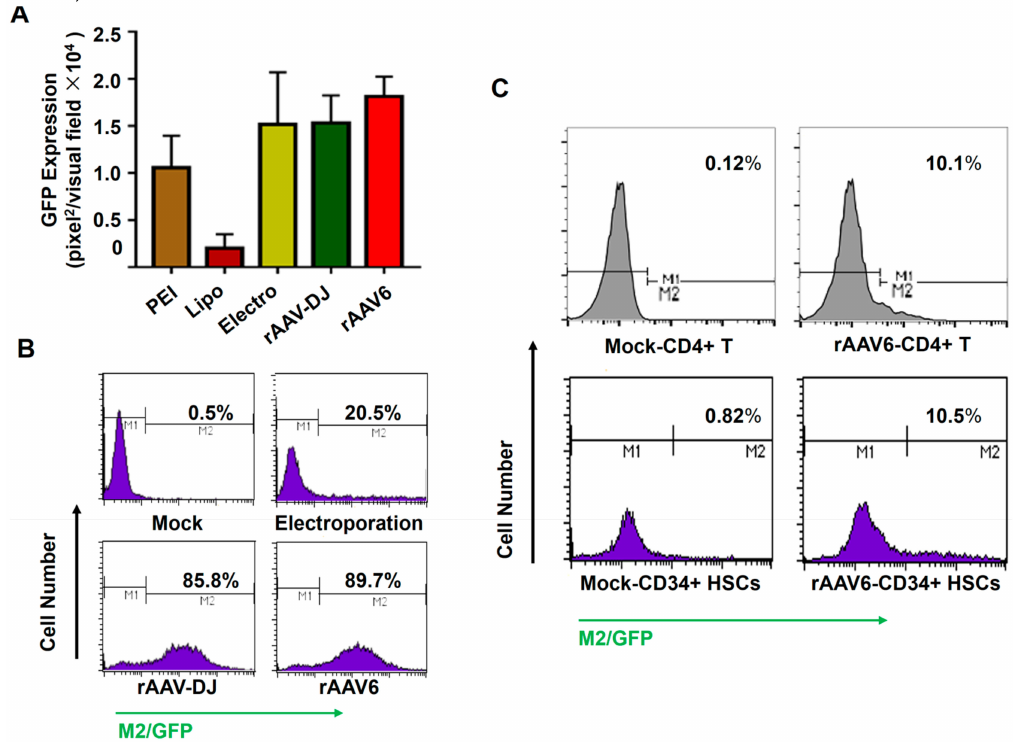
Figure 1. Capsid-optimized recombinant adeno-associated virus serotype 6 (rAAV6) vectors represented the most e ffi cient gene delivery method for hematopoietic cells. ( A ) K562 cells were transduced with the gfp gene through various indicated methods. Transgene expression was detected by fluorescence microscopy at 72 hours post-transfection or post-viral transduction. ( B ) Transgene expression from ( A ) was measured by flow cytometry. ( C ) Primary human CD4 + T cells and CD34 + hematopoietic stem cells (HSCs) were transduced with rAAV6-CMVp- gfp vectors at 10,000 vgs / cell. Transgene expression was detected by flow cytometry at 72 hours post-transduction. PEI: